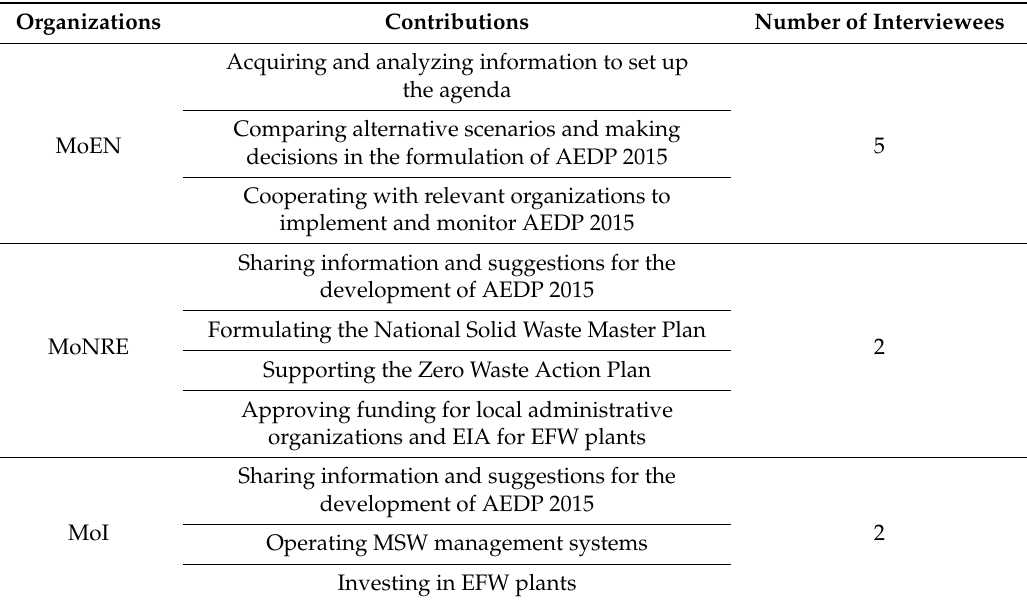
Table 4. Details of